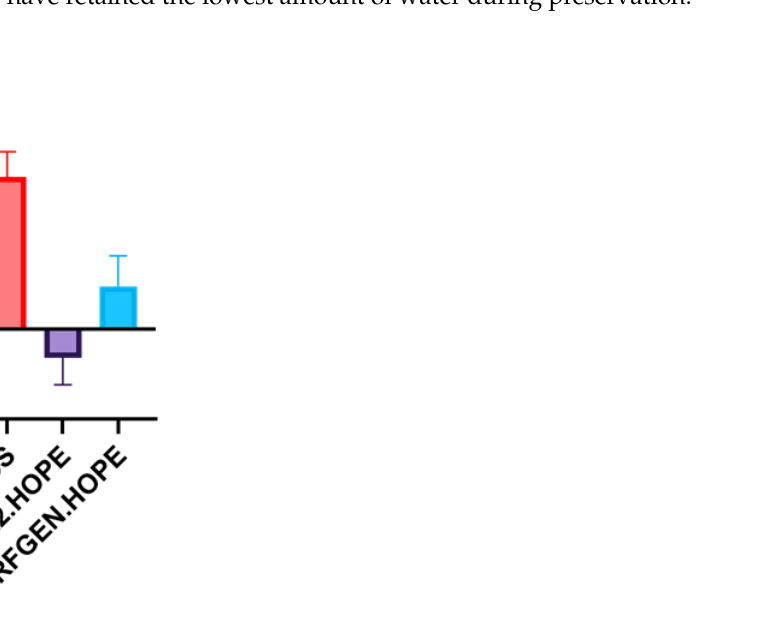
Figure 9. The percentage of weight change between the PRE-SCS and POST-SCS phases shows that the livers from the IGL2 groups seemed to have lost weight after NMP throughout preservation. In contrast, the livers from the BELGEN and PERFGEN groups tended to follow the opposite trend. n = 6/group .